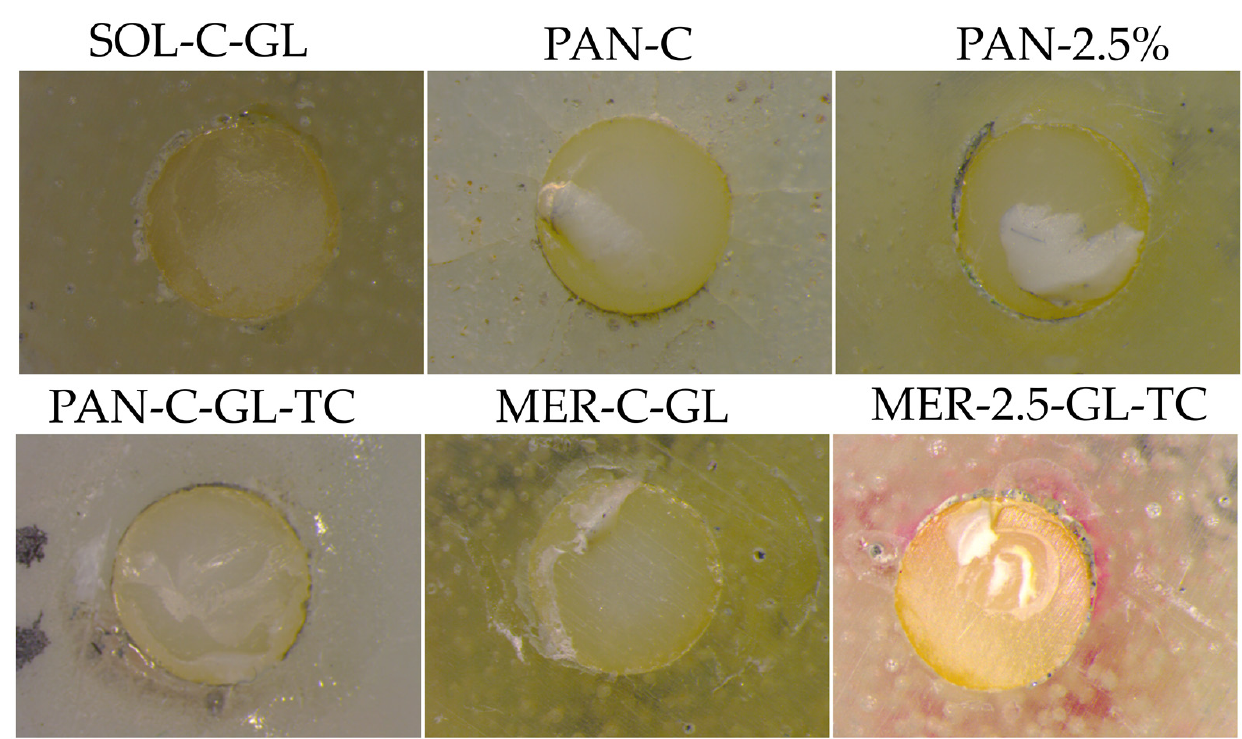
Figure 5. Indicative images from the stereomicroscope of different types of adhesive failure modes. SOL − C − GL = Solocem Control after Gluma application, PAN − C = Panavia SA Universal Control, PAN − 2.5% = Panavia SA Universal with 2.5% wt zirconia NPs, PAN − C − GL − TC = Panavia SA Uni- versal Control after Gluma application and thermal cycling, MER − C − GL = Meron plus QM Control after Gluma application, MER − 2.5 − GL − TC = Meron plus QM WITH 2.5% zirconia NPs after Gluma application and thermal cycling.